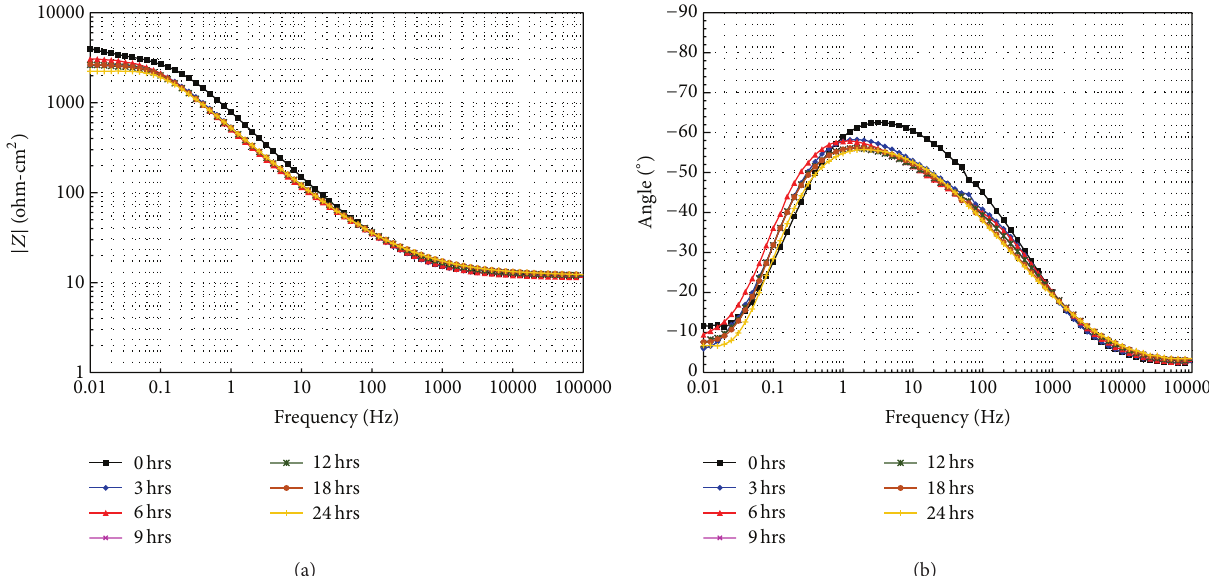
Figure 12: Bode plots for 30Nd10Pr magnet tested in 3.5% NaCl solution at 25 ∘ C for 24 hours.